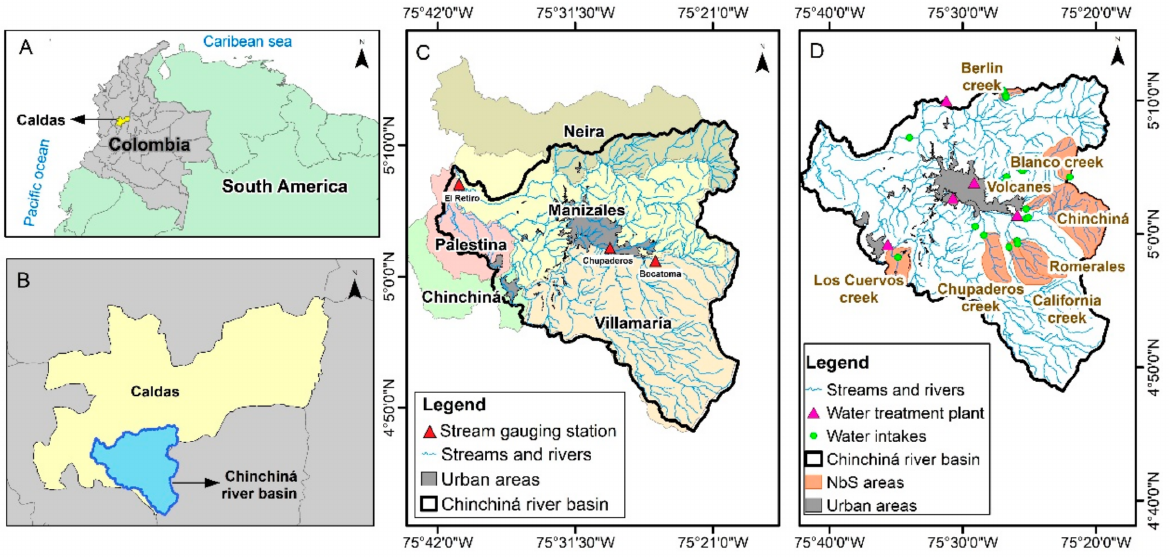
Figure 10. The geographic location of the Chinchin á river basin (maps ( A ) and( B )), the setting of cities and villages in the basin (map ( C )), and areas where NbS will be implemented (map ( D